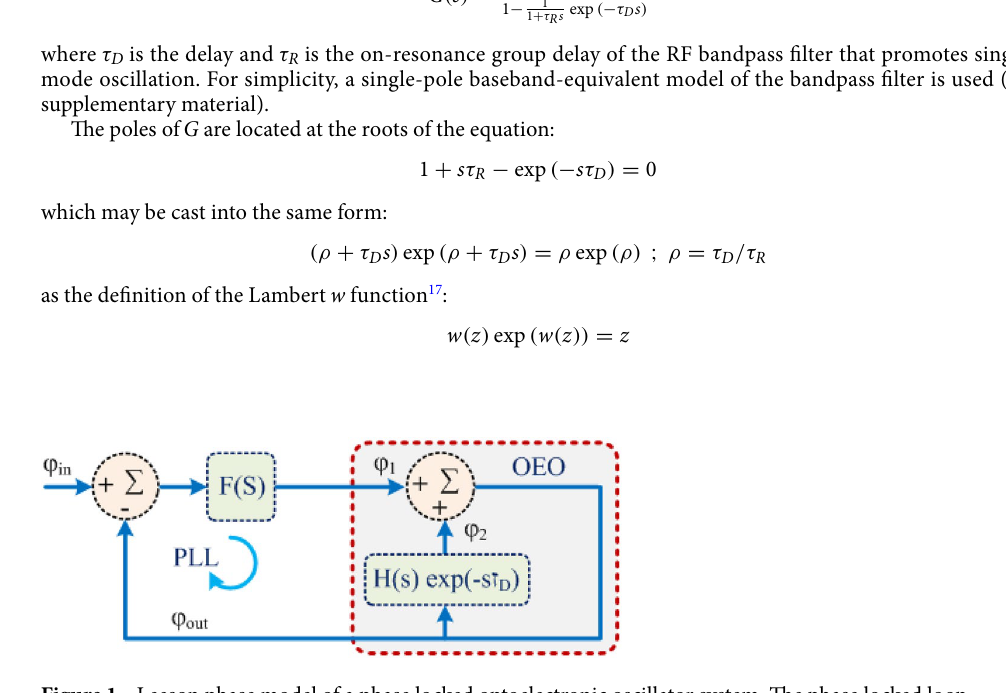
Figure 1. Leeson phase model of a phase locked optoelectronic oscillator system. The phase locked loop forms a negative feedback loop composed of the phase sensitive detector (PSD), loop filter, and optoelectronic oscillator (OEO). The PSD is depicted by the signed summation block on the left that measures the phase error φ in φ out . The loop filter is depicted by a block labelled by its system function F . The OEO is depicted by the − contents of the red dashed box that form a positive feedback loop. The rectangle represents the combined action in the Laplace transform domain of the fibre optic delay line and RF bandpass filter, where τ D is the time delay and H is the baseband equivalent system function of the RF bandpass filter. The summation block represents a phase shifter that introduces a single pass phase shift equal to the tuning control φ 1